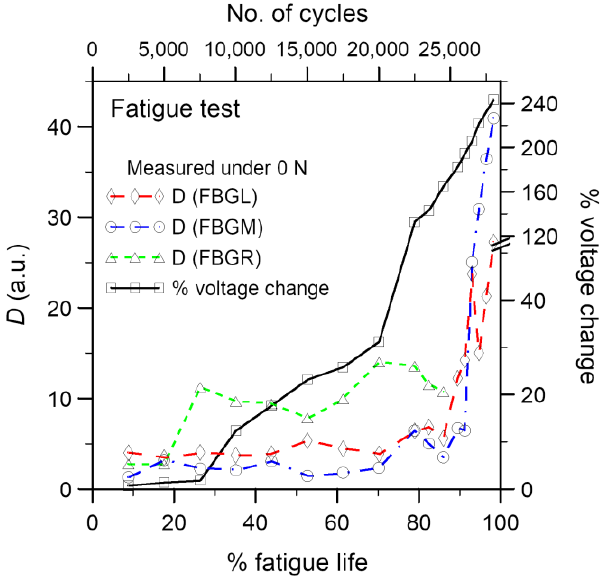
Figure 11. Load-free D values from three FBGs and the percentage voltage change development in a typical fatigue specimen.